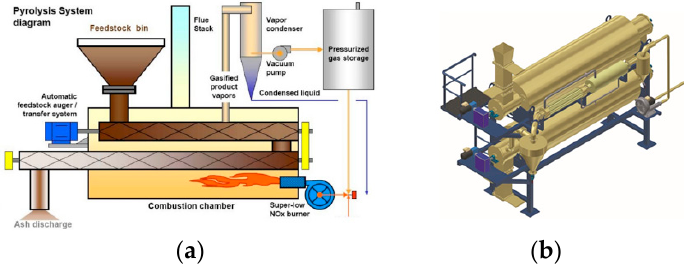
Figure 2. ( a ) Schematic of a municipal solid waste (MSW) gasifier and pyrolysis reactor; ( b ) Pyrolysis